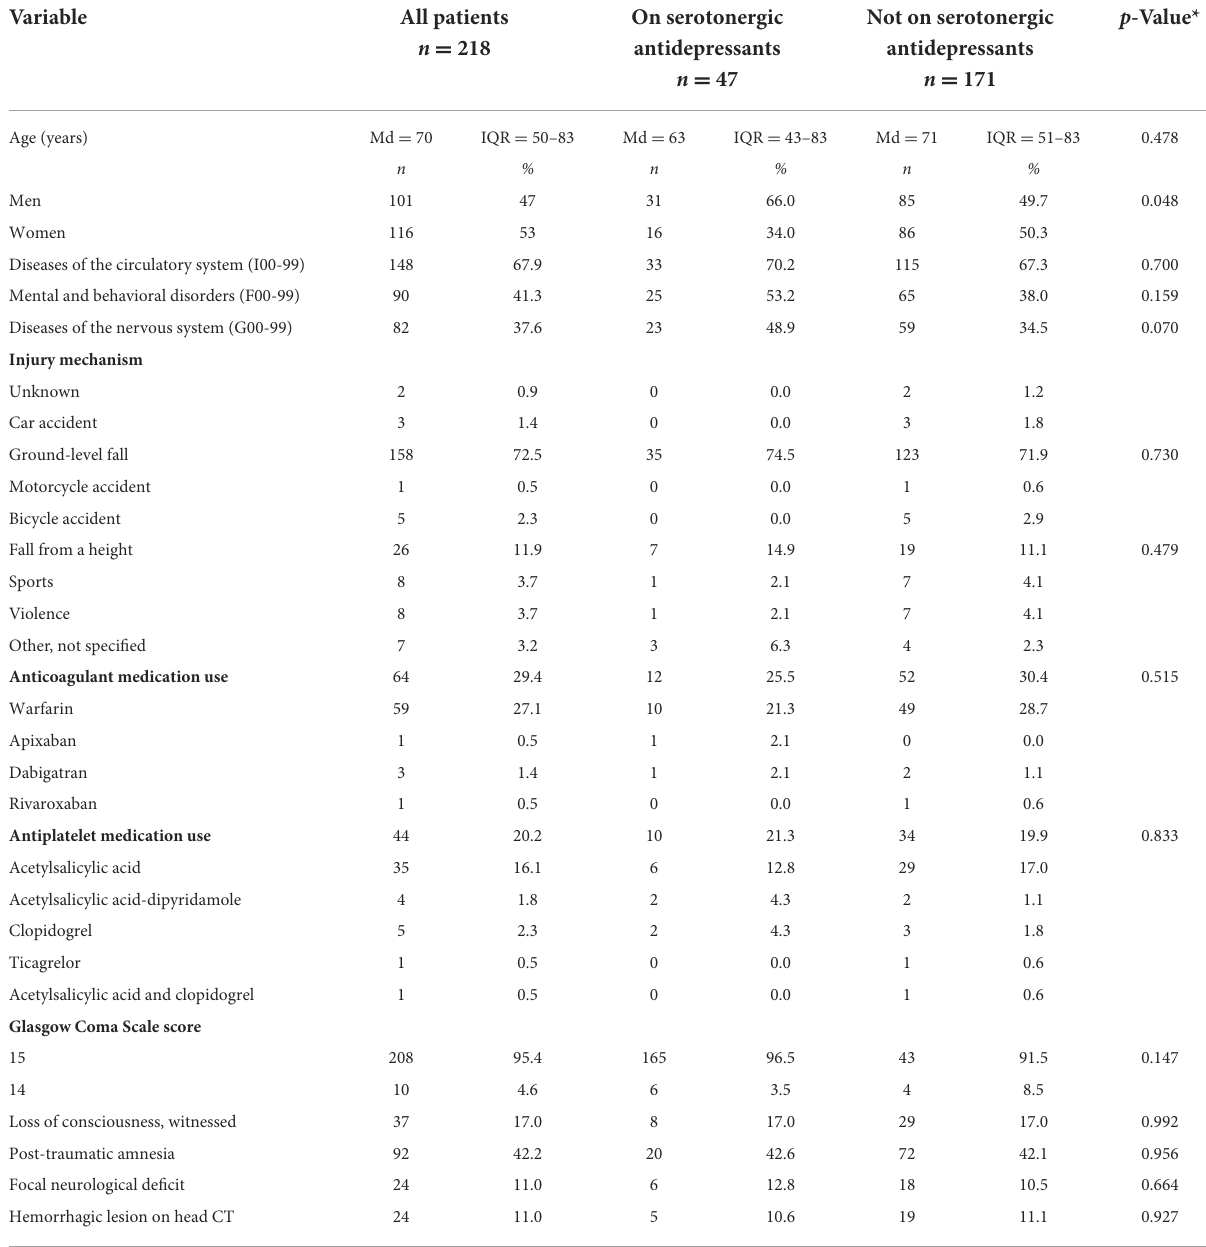
TABLE 1 Characteristics of the study